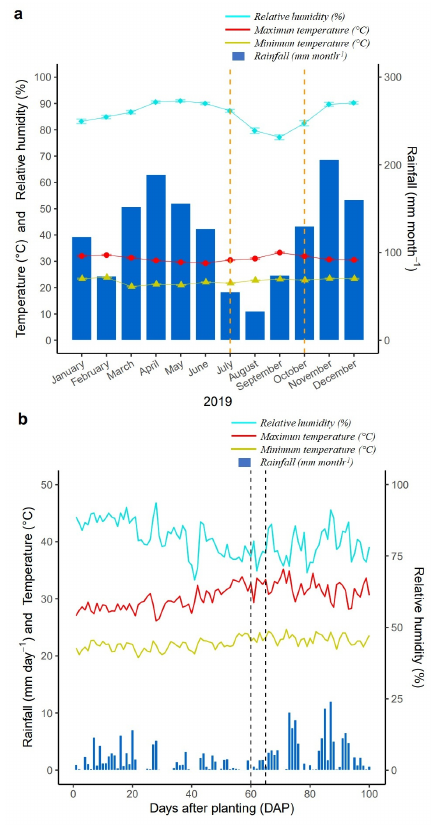
Figure 8. Distribution of rainfall, relative humidity, and maximum/minimum temperatures during: ( a ) the year 2019; ( b ) the crop growth period (July to October) at the CIMAZ Macagual Amazon Research Center in Colombia. The orange dashed vertical lines shown in panel ( a ) indicate the crop growth period (between the months of July and October), and the black dashed vertical lines shown in panel ( b ) indicate the crop growth phase (BBCH 79: between 60 and 65 DAP) during which the chlorophyll fluorescence measurements were obtained.